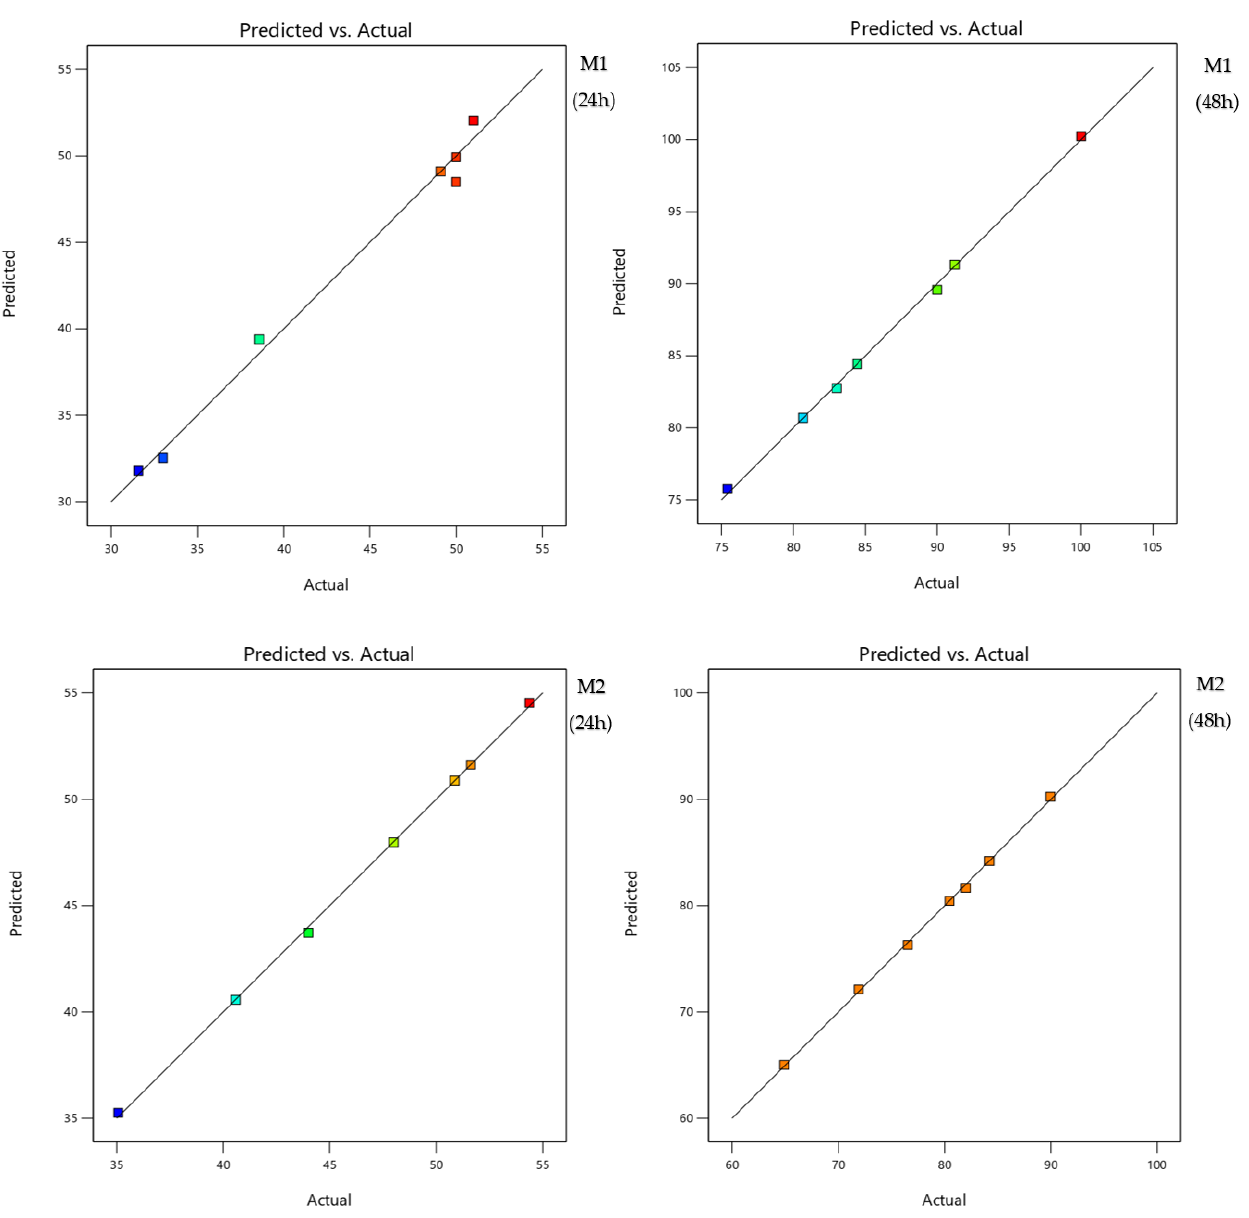
Figure 2. Curves of the predicted values according to the actual ones for both binary mixtures.